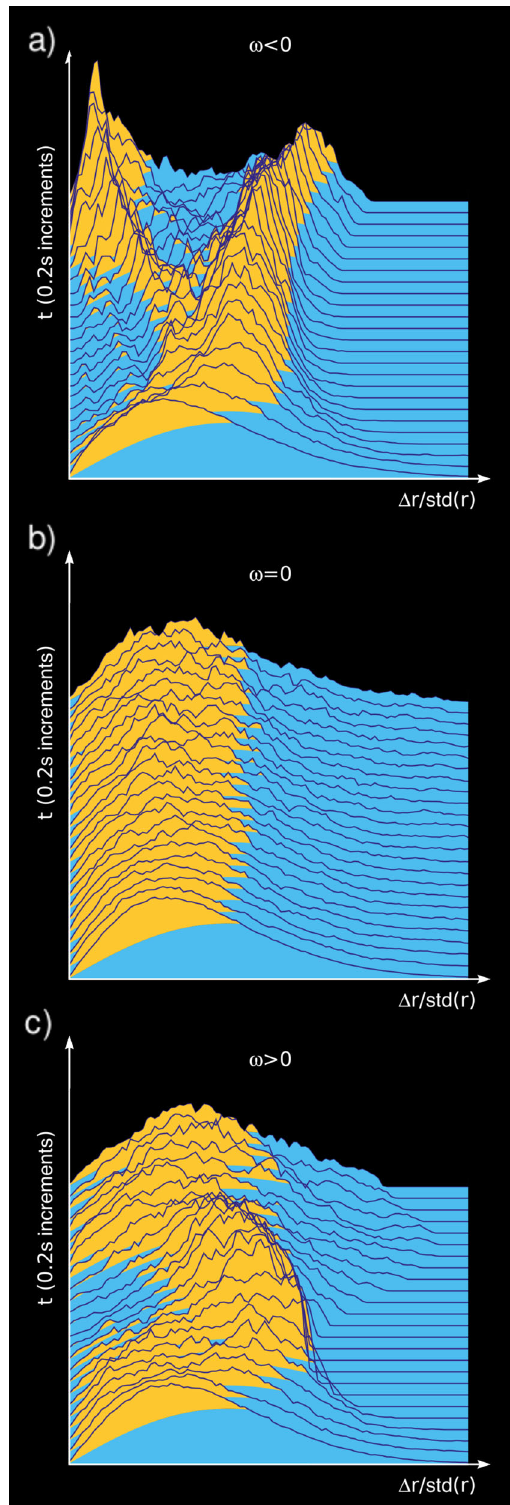
Fig. 2 Time evolution of the distribution function of the root of the reduced square displacements, f ( Δ r /std( Δ r )). We display results for a ω ¼ (cid:2) 0 : 15s (cid:2) 1 , b ω ¼ 0 : 08s (cid:2) 1 and c ω ¼ 0 : 23s (cid:2) 1 (indicated as ω < 0, ω ¼ 0, ω > 0 respectively), with packing fraction ϕ = 0.45. Being std( Δ r ) the standard deviation of Δ r . In orange, the areas where f ( Δ r /std( Δ r )) > f G and blue where f ( Δ r /std( Δ r )) < f G (here, f G is the normal Gaussian